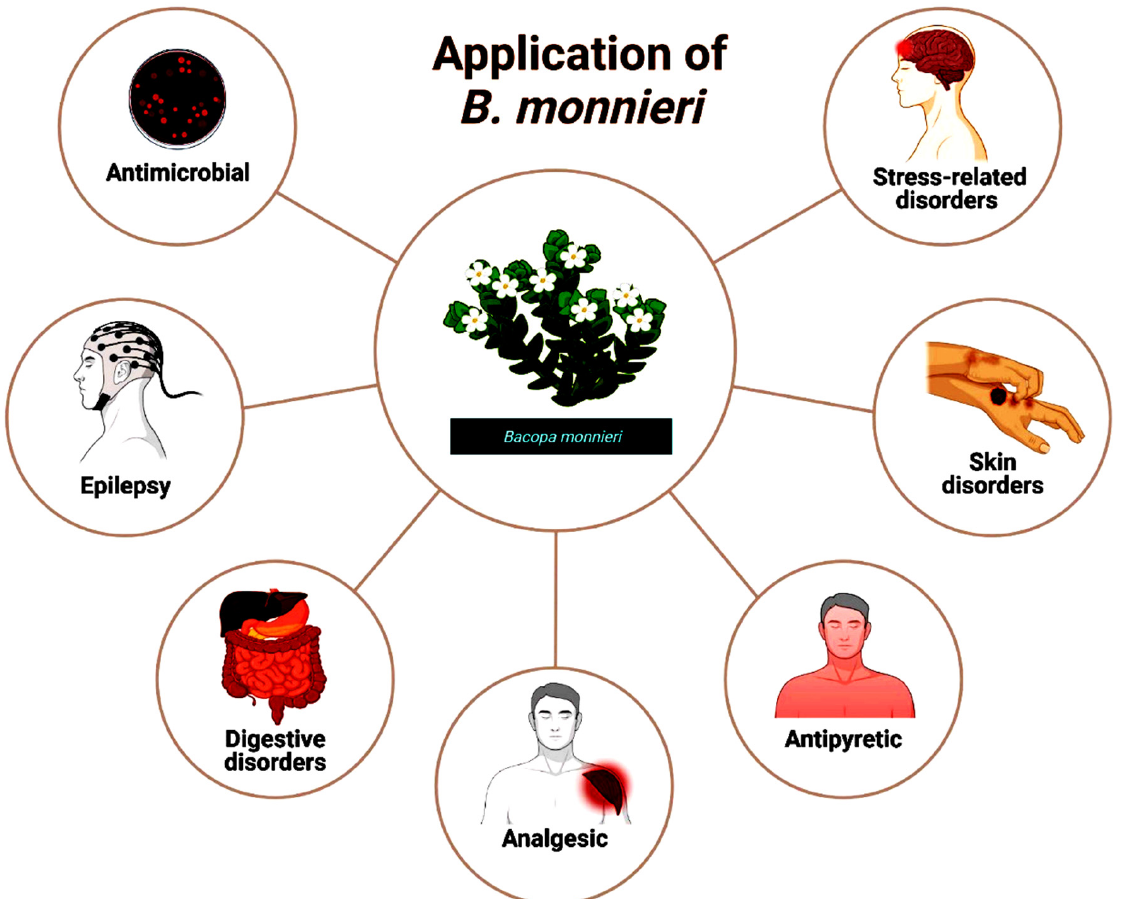
Figure 1. The use of B. monnieri to treat a variety of illnesses, including inflammations, cognitive problems, and gastrointestinal problems.